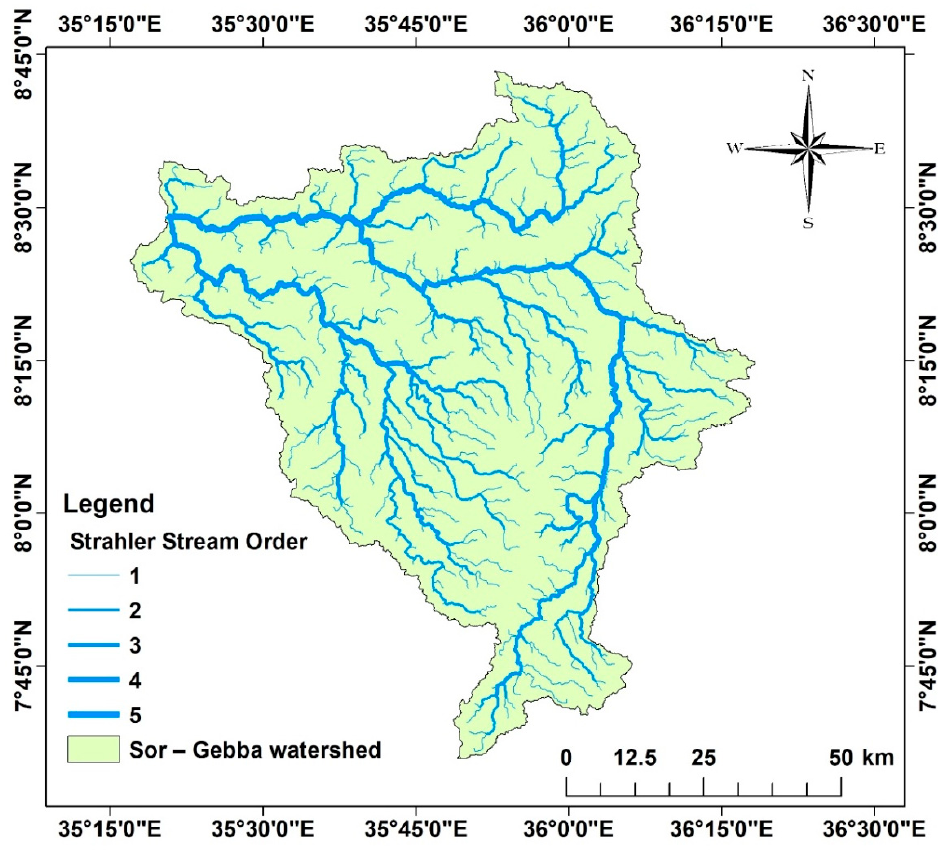
Figure 2. Strahler stream order designation for the Sor and Gebba streams.